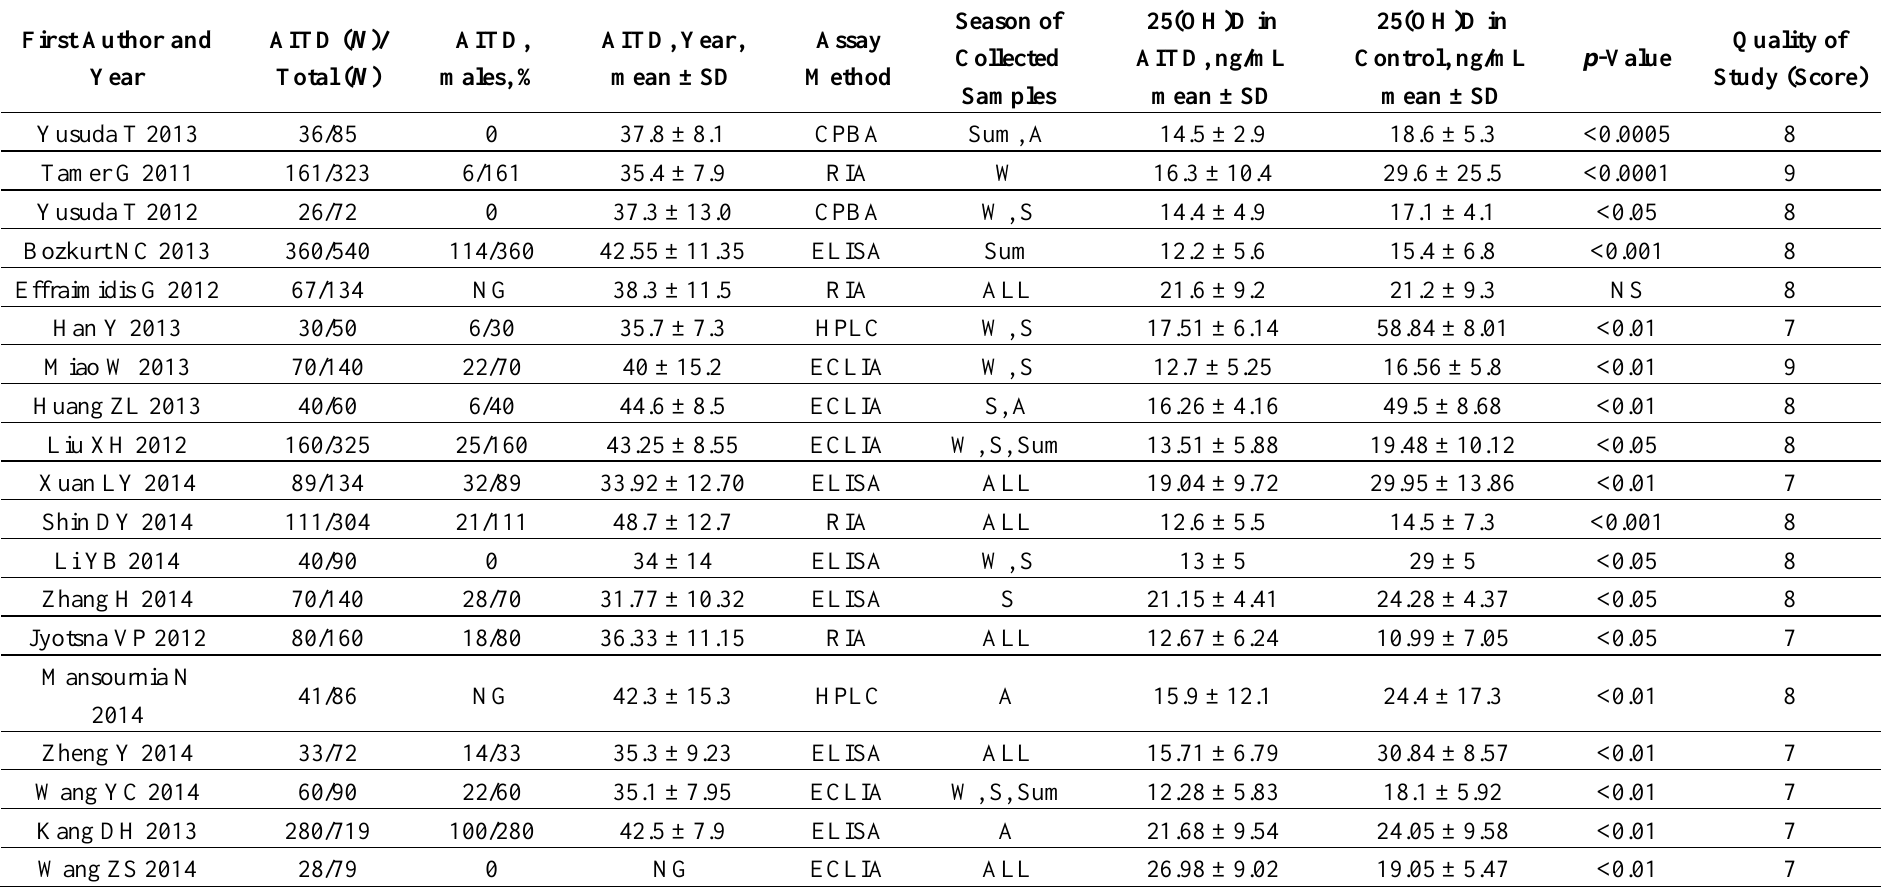
(Introductions of Table 1: (1) Assay method: ELISA, enzyme-linked immunosorbent assay; HPLC, high performance liquid chromatography; ECLIA, chemiluminescence immunoassay; CPBA, competitive protein binding assay; RIA, radioimmunoassay; (2) Season: S, spring; Sum, summer; A, autumn; W, winter. (3) N , number; NG, not given; NS, not